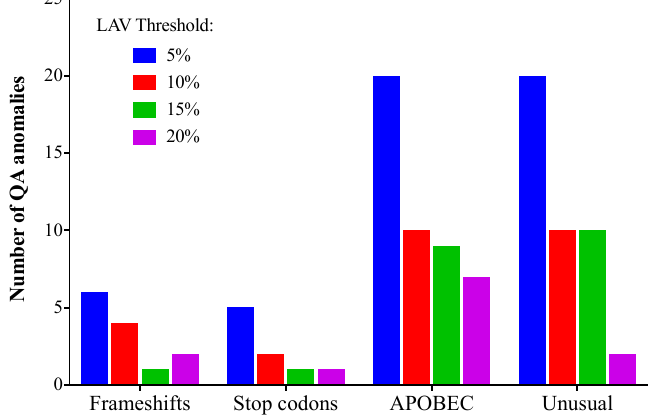
Figure 4. Sequence quality assurance anomalies (total for all laboratories) at different low-abundance variant (LAV) thresholds. Sequence quality evaluation was performed with Stanford HIVdb (https: // hivdb.stanford.edu / ). HIVdb sequence analysis was performed using NGS sequences generated using the 5%, 10%, 15%, or 20% threshold